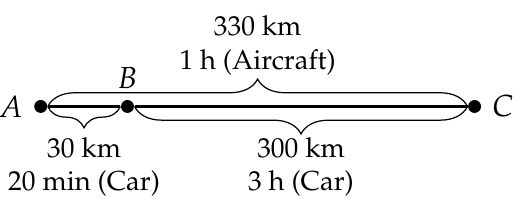
Figure 1. Space inversion between three places located in geographical space (kilometres) and in geographical time-space